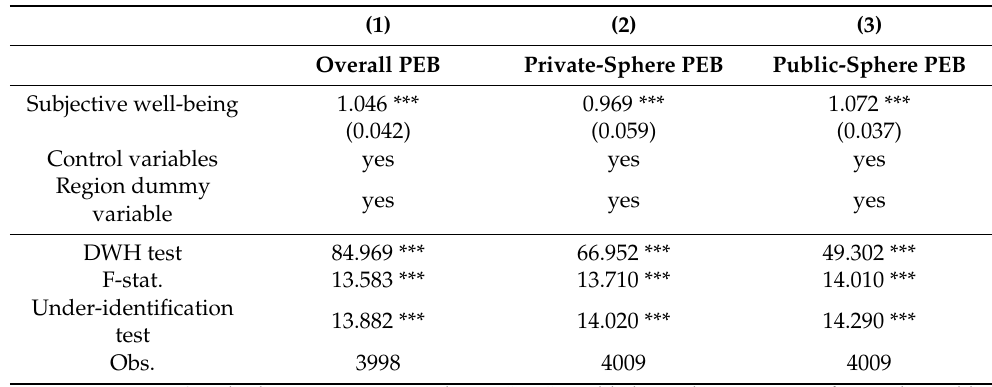
Table 3. The influence of subject well-being on PEB: endogeneity